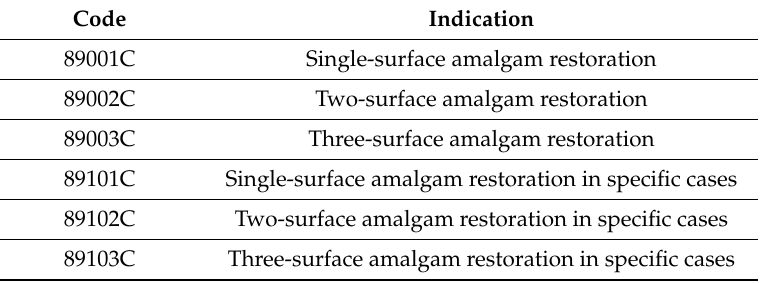
Table 1. National health insurance treatment codes for an amalgam filling.